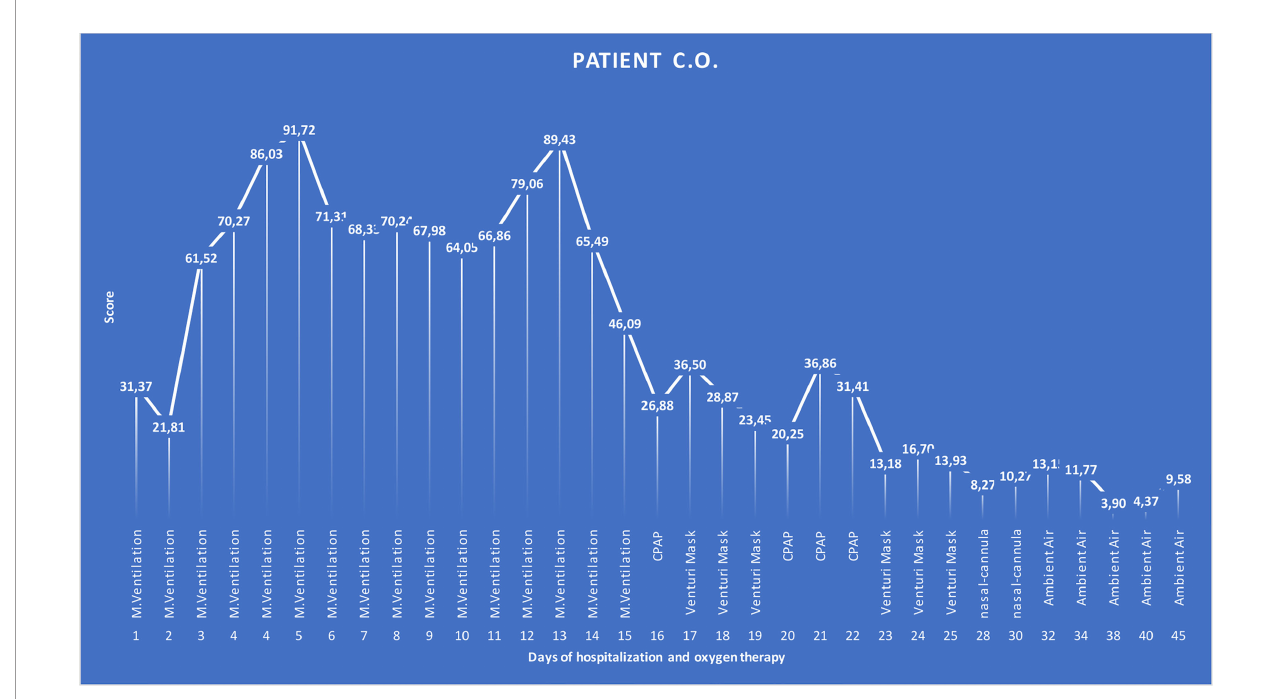
FIGURE 4 | Graphical representation of a COVID-19 patient over the time of 45 days of hospitalization that went through different phases of the disease severity according to the OXY therapy. The patient was considered to be in critical condition upon admission to the hospital and, according to this, supported by CPAP OXY therapy for 16 days (17 score time points — 1 day had two BCC and then two scores). After clinical improvement, for the next 9 days (9 score time points), the OXY therapy was alternated between CPAP and a lower grade of support, as Venturi mask is. The patient further improved, and accordingly, the type of the OXY therapy changed to the nasal-cannula on day 28 till 5 days before the discharge when the patient did not require any OXY support. Score values are reported as labels. M. ventilation, mechanical ventilation; CPAP, continuous positive airway